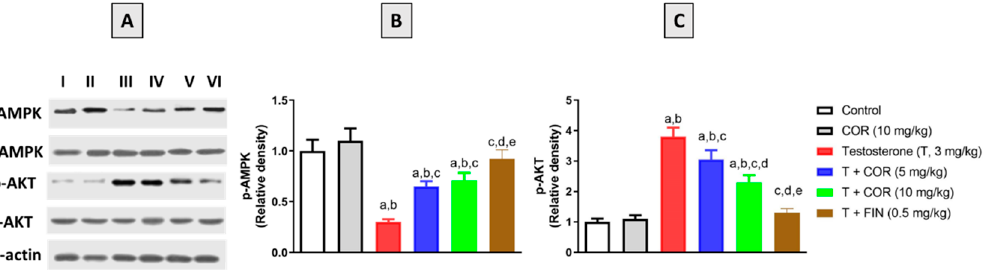
Figure 5. Effect of cordycepin on prostatic protein expression of p-AKT and p-AMPK ( A ) in testosterone-treated rats. Lanes I, II, III, IV, V, and VI represent control, cordycepin, testosterone, testos- terone + cordycepin 5 mg/kg, testosterone + cordycepin 10 mg/kg, and testosterone + finasteride, respectively. Densitometric data of p-AKT and p-AMPK expression presented in bar charts ( B , C ) are mean ± SD ( n = 6). COR = cordycepin, T = testosterone, FIN = finasteride. a, b, c, d or e: signifi- cantly different ( p < 0.05) from control, cordycepin, testosterone, T + COR (5 mg/kg) or T + COR (10 mg/kg), respectively.